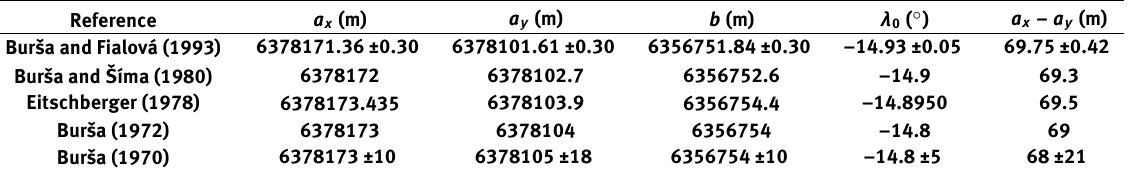
Table 1. Parameters of Earth’s triaxiality in the satellite